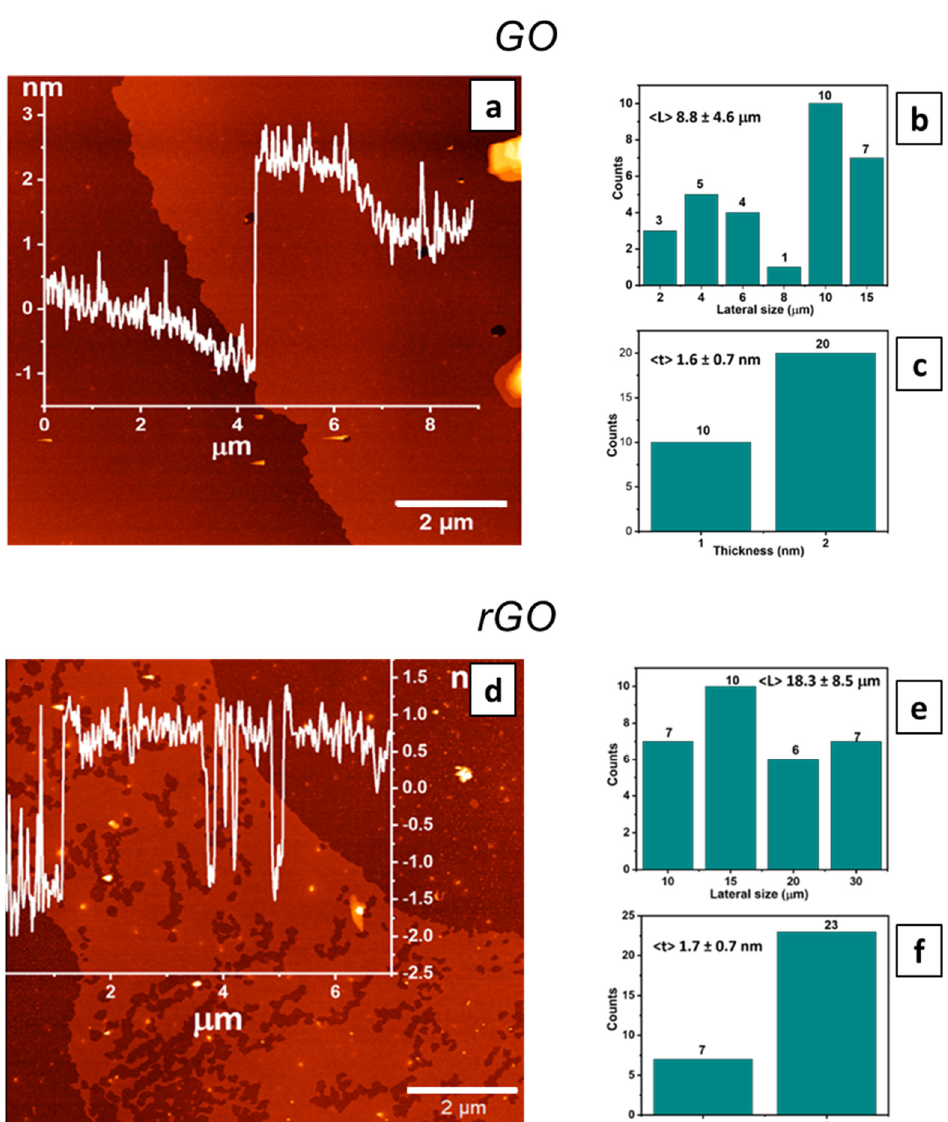
Figure 1. ( a ) Representative AFM image with a cross-sectional profile; average dimensional analyses of ( b ) the lateral size and ( c ) thickness distribution of GO flakes in ethanol dispersions. ( d ) Representative AFM image with a cross-sectional profile; average dimensional analyses of ( e ) the lateral size and ( f ) thickness distribution of rGO flakes in ethanol dispersions.